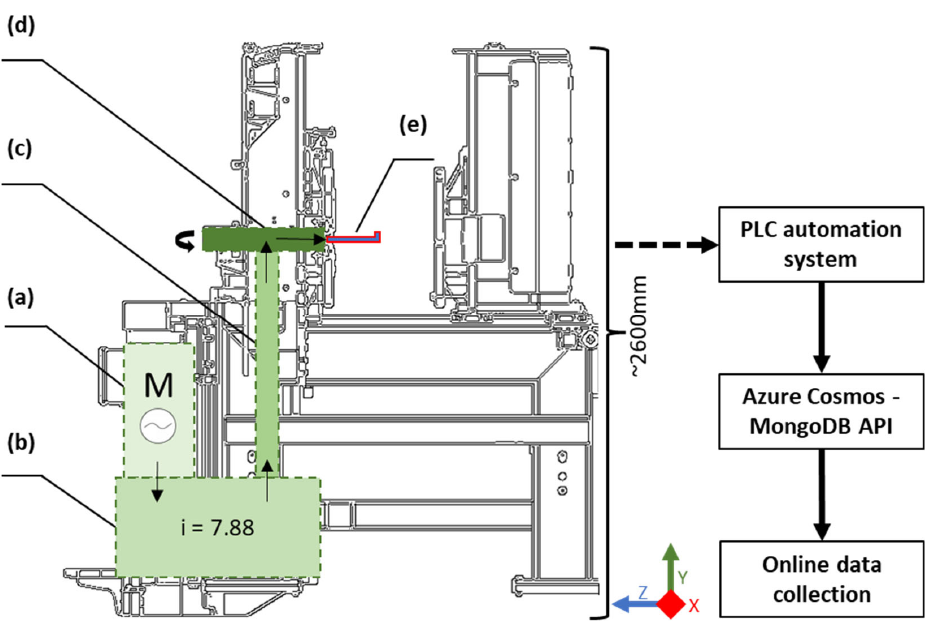
Figure 1. The peripheral milling process’s main physical components are ( a ) AC electric motor, ( b ) gearbox, ( c ) shaft, ( d ) spindle, and ( e ) milling position (x-axis direction feed). The data flow to the internet-connected data collection system is connected through the integrated PLC system and Azure Cosmos MongoDB API.